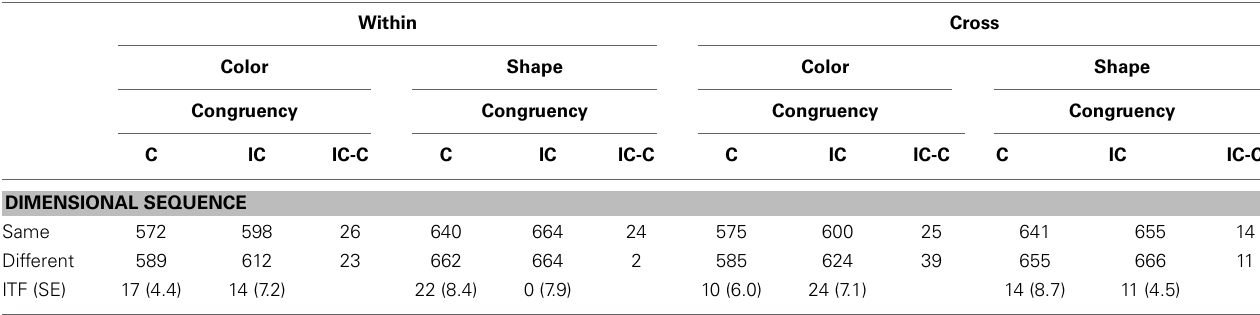
Table 9 | Mean correct reaction times in trial n as a function of the dimensional sequence of target-defining feature with trial n − 1 and the response congruency of trial n in Experiment